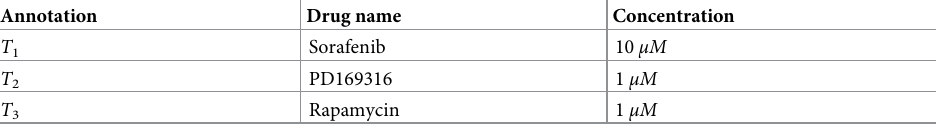
Table 1. Single drugs used as candidate treatments in the pharmacological case